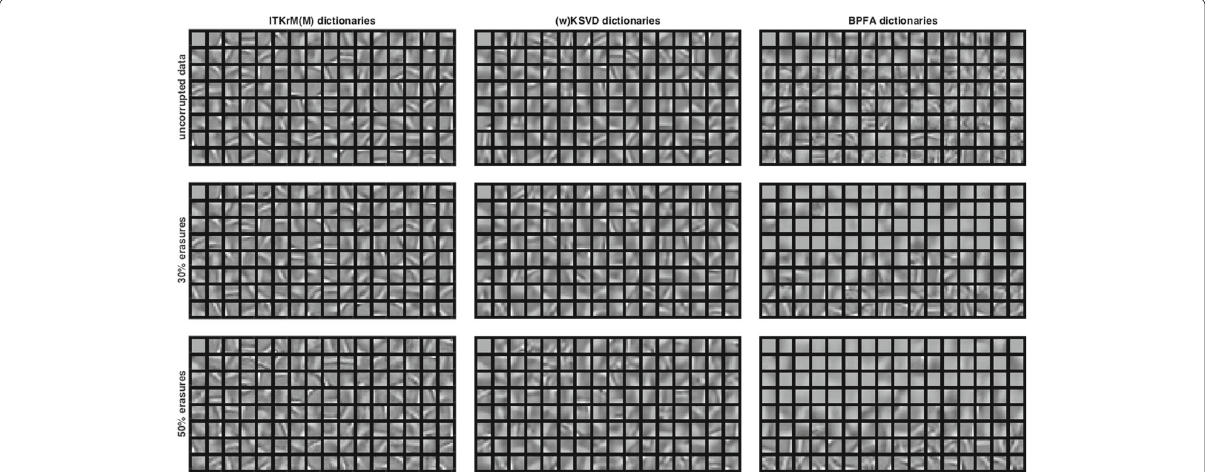
Fig. 6 Dictionaries and low-rank atom (left upper corner) learned with ITKrM(M) (left), (w)KSVD (middle) and BPFA (right) algorithms on all 8 × 8 patches of Peppers without corruption (top), 30% erasures (middle) and 50% erasures (bottom)